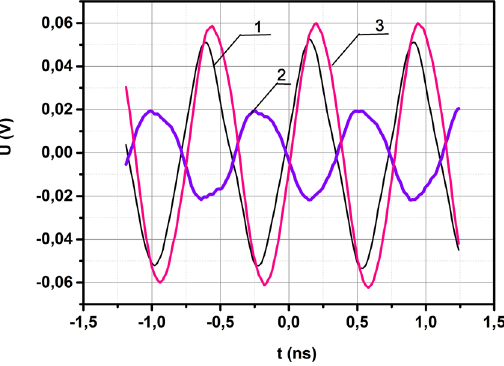
Figure 5. Waveforms of electric field component near the dielectric ring. ( 1 ) Reference probe. ( 2 ) Second probe near the back side of dielectric ring kept away from antenna. ( 3 ) Second probe near the front side of dielectric ring to antenna.